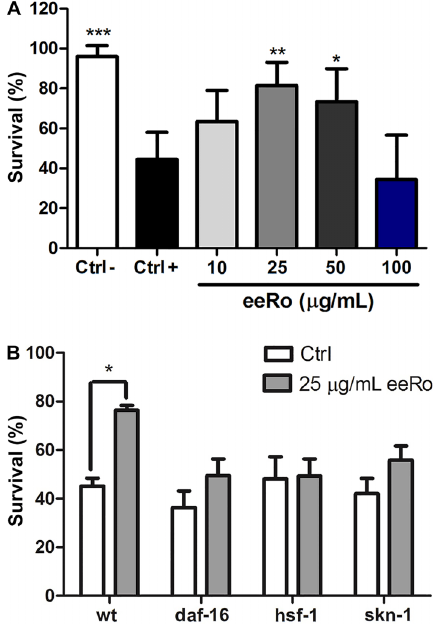
Figure 1. Effect of ethanolic extract of Rosmarinus of fi cinalis L. (eeRo) on juglone-induced mortality. Survival of wild-type ( A ) and mutant worms ( B ) treated with eeRo and exposed to 100 m M juglone for 1 h (Ctrl + ). Data are reported as percentage of living worms of 100 worms per group in each experiment from 4 independent assays. A , *P o 0.05, **P o 0.01, ***P o 0.001, com- pared to the Ctrl + group (one-way ANOVA). B , *P o 0.05 (two-way